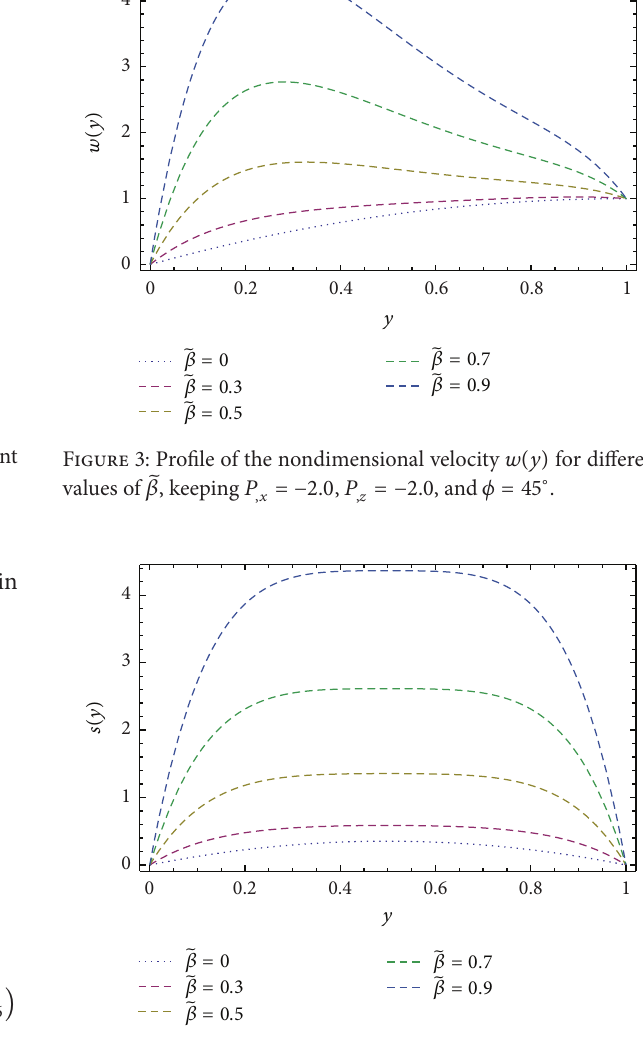
Figure 4: Profile of the nondimensional velocity 𝑠(𝑦) for different ̃𝛽 values of , keeping 𝑃 ,𝑥 = −2.0 , 𝑃 ,𝑧 = −2.0 , and 𝜙 = 45 ∘